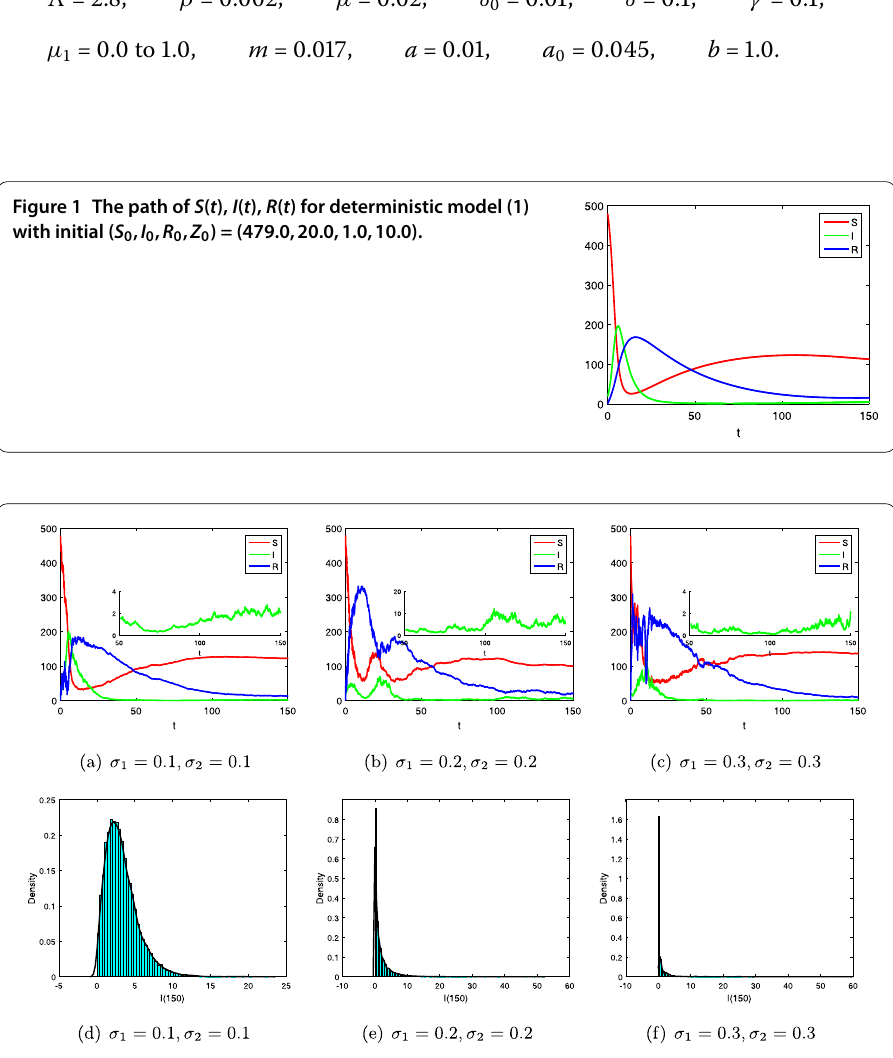
Figure 2 The path of S ( t ), I ( t ), R ( t ) for model (2) and the histogram of the probability density function of I (150) with initial ( S 0 , I 0 , R 0 , Z 0 ) = (479.0,20.0,1.0,10.0) under different noise